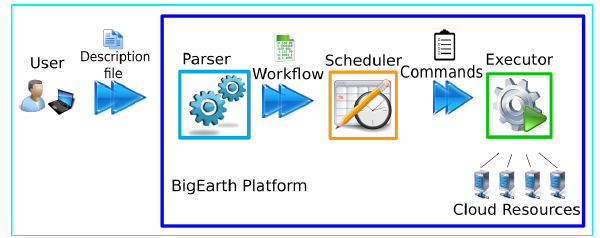
Figure 1. BigEarth platform processing chain